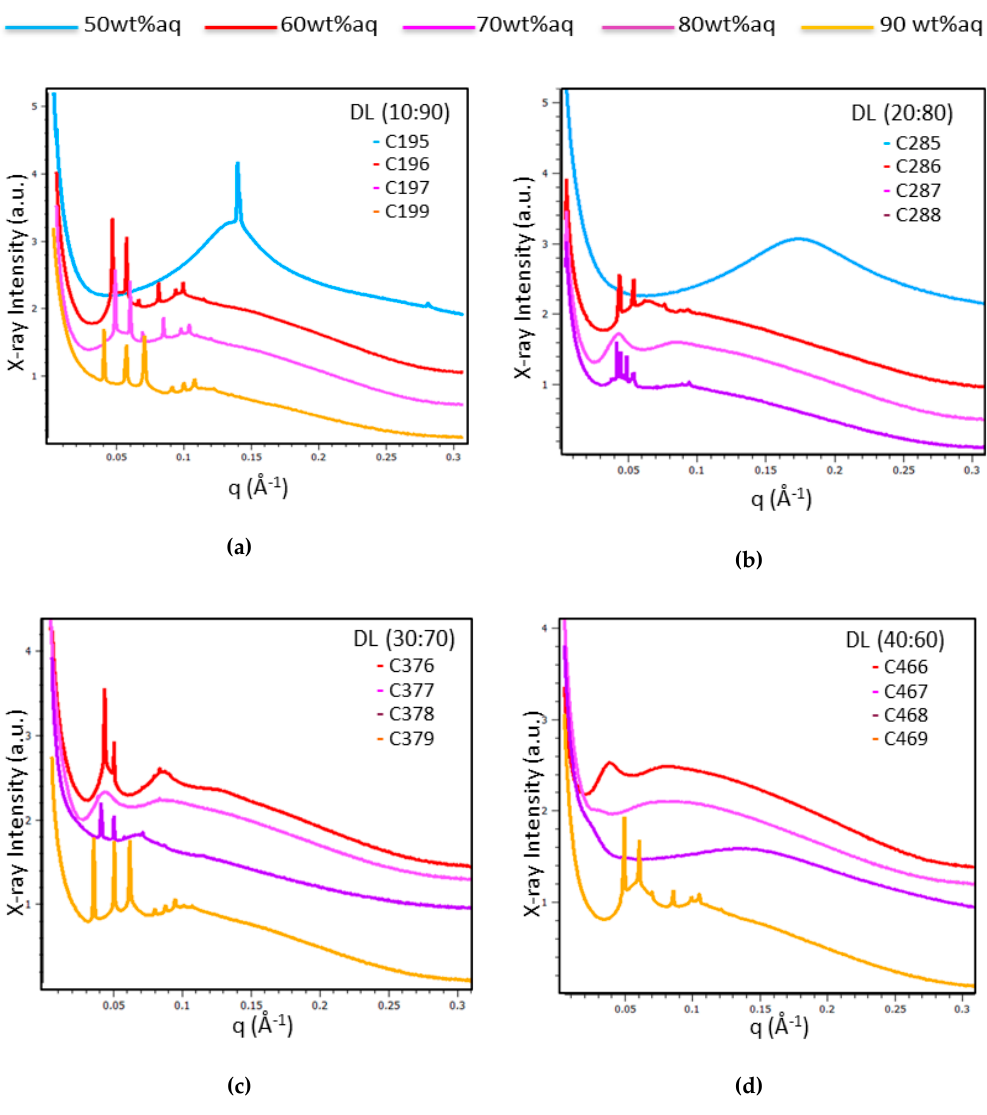
Figure 4. BioSAXS patterns of MO/TPEG 1000 /FO/CU/CAT assemblies acquired at 22 °C along the = 10:90; ( b ) DL = 20:80; ( c ) DL = 30:70; and ( d ) DL = 40:60 from Figure dilution lines (DL): ( a ) DL = 10:90; ( b ) DL = 20:80; ( c ) DL = 30:70; and ( d ) DL = 40:60 from Figure 2 dilution lines (DL): ( a ) DL